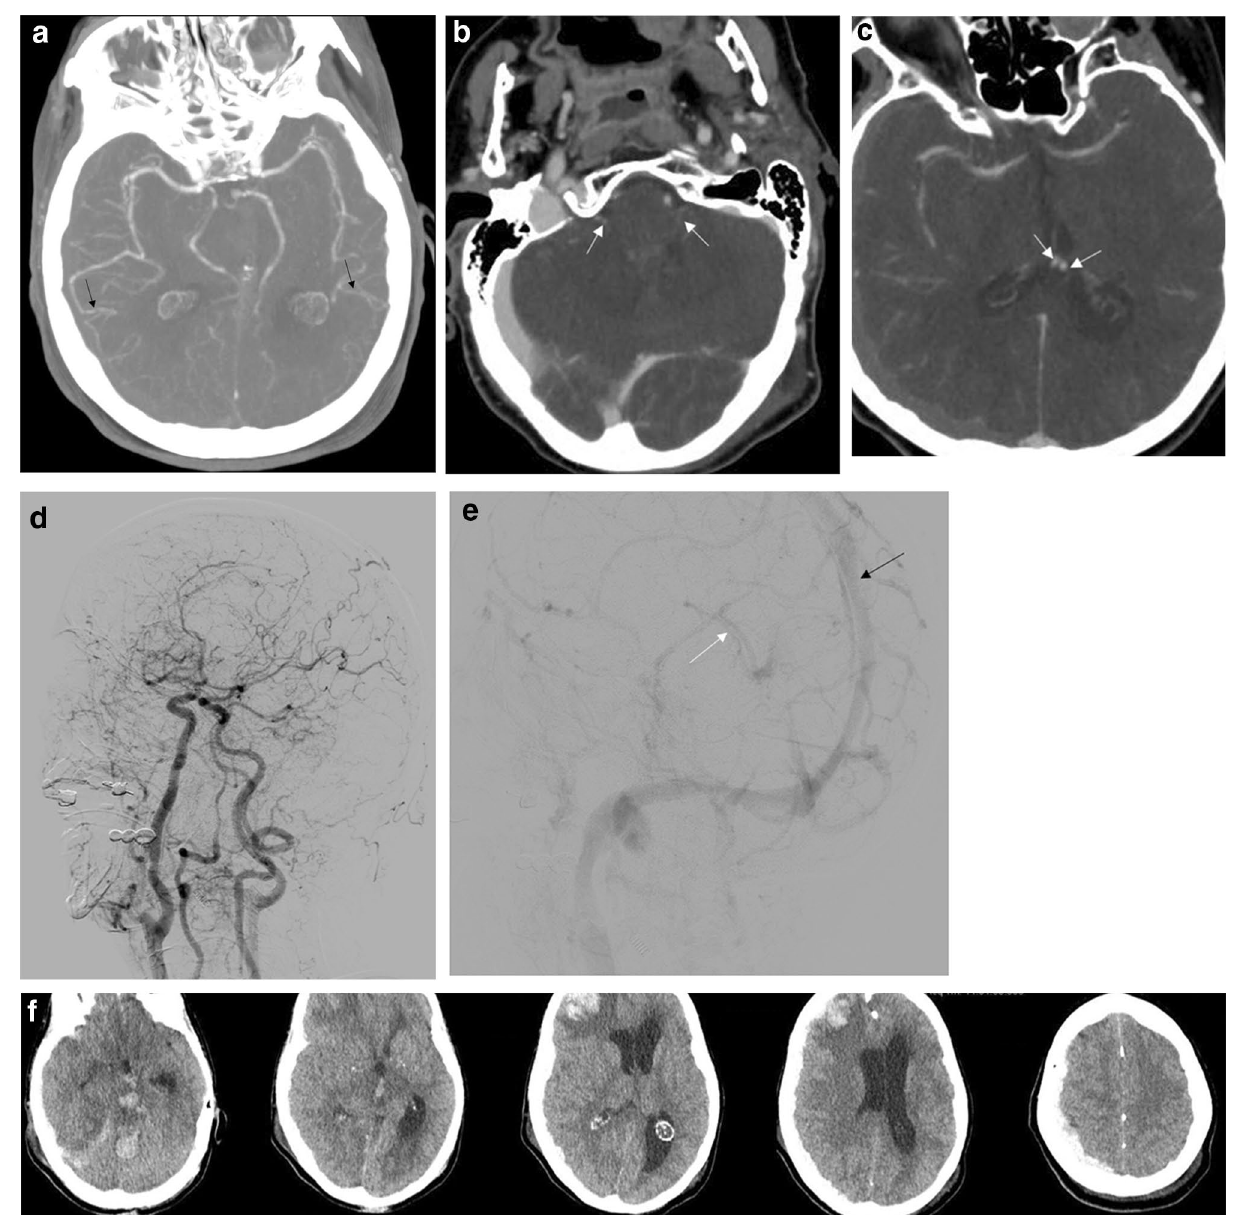
Figure 1. ( a ) Axial CTA-MPR (arterial phase) reveals good patency to all arterial intracranial vessels (including M4 segments-black arrows). ( b ) Axial CTA at the same patient (60 s phase), shows opacification of both superior petrosal veins (white arrows). ( c ) Axial CTA at the same patient (60 s phase), shows opacification of both internal cerebral veins (white arrows). ( d ) Digital Subtraction Angiography at the same patient in arterial phase (LAO oblique view), reveals good flow in all proximal and distal intracranial arteries of the anterior and posterior circulation. ( e ) Digital Subtraction Angiography at the same patient in venous phase (LAO oblique view), shows that superficial (black arrow) and deep venous system (white arrow) is patent. ( f ) Axial plain brain CT at different levels, shows adequate differentiation of gray-white matter and no radiologic signs of brain death, 15 days following the initial angiographic check of the same